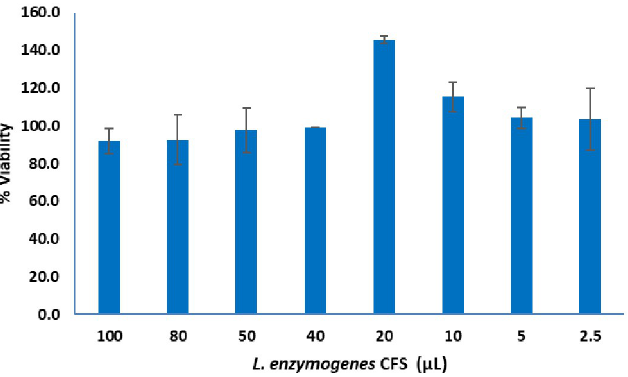
Fig 5. Viability of human normal skin fibroblast (CCD-1064SK) at different concentrations (1.25, 2.5, 5, 10, 20, 25, 40, and 50% (v/v)) of L . enzymogenes CFS as assessed by MTT